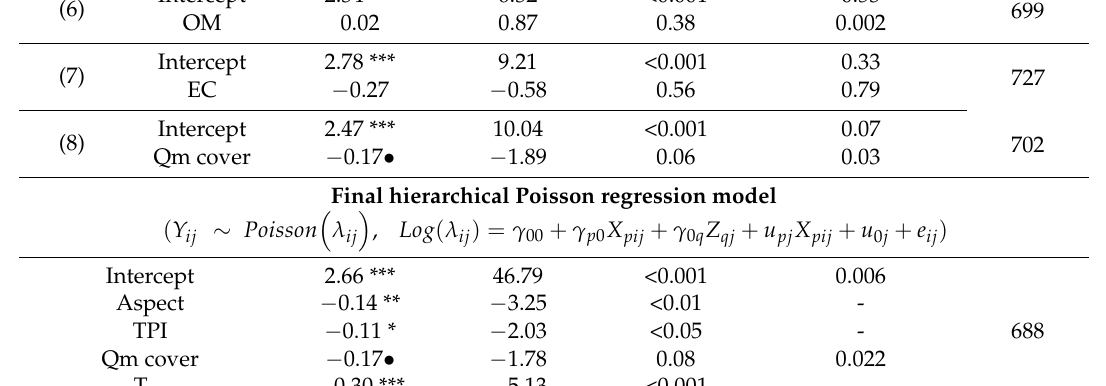
(cid:17) (cid:16) X ij and site-level explanatory variables